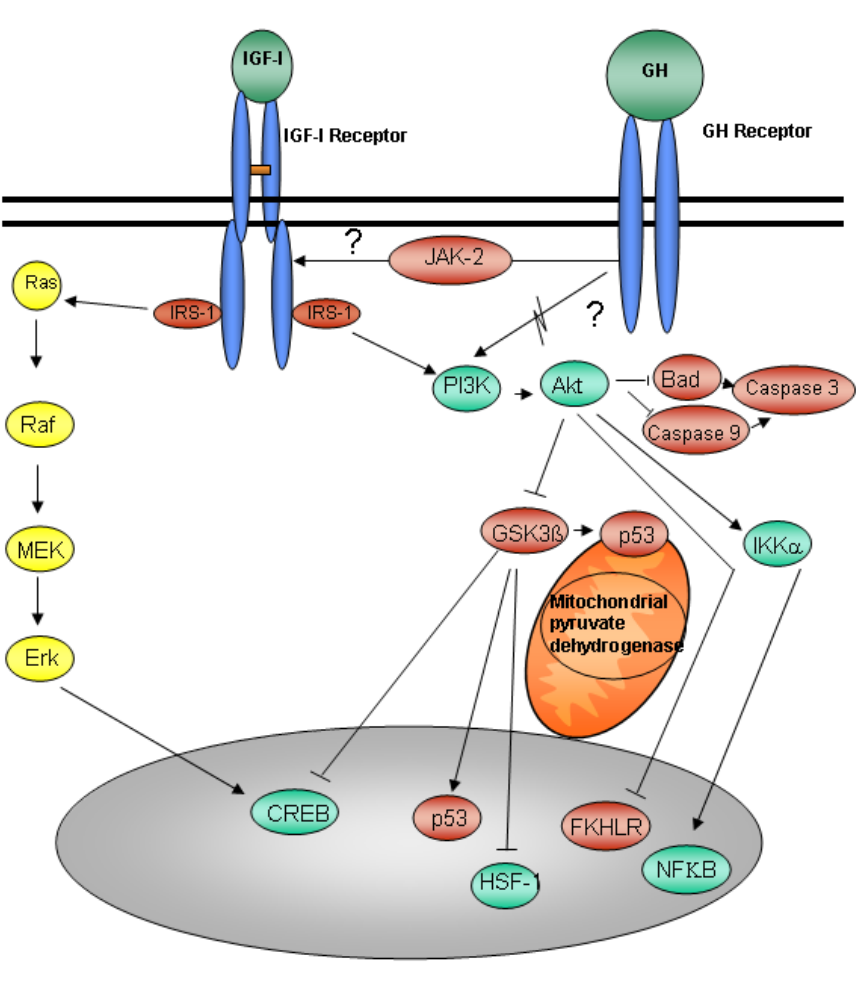
FIGURE 3. Proposed signaling pathways for IGF-I and GH with regard to cell survival. IGF-I binding to its receptor leads to activation of the PI3K/Akt or MAPK (mitogen-activated protein kinase =